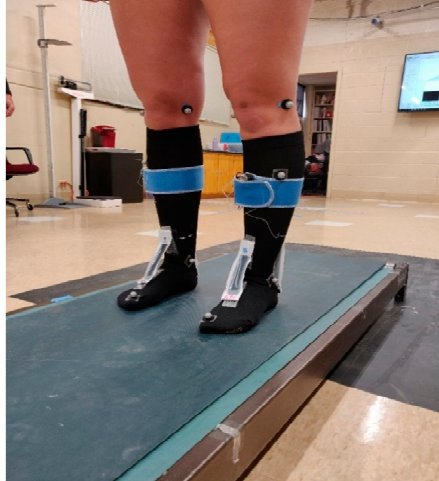
Figure 1. Arrangement of SRS and motion capture marker setup to capture and assess sagittal